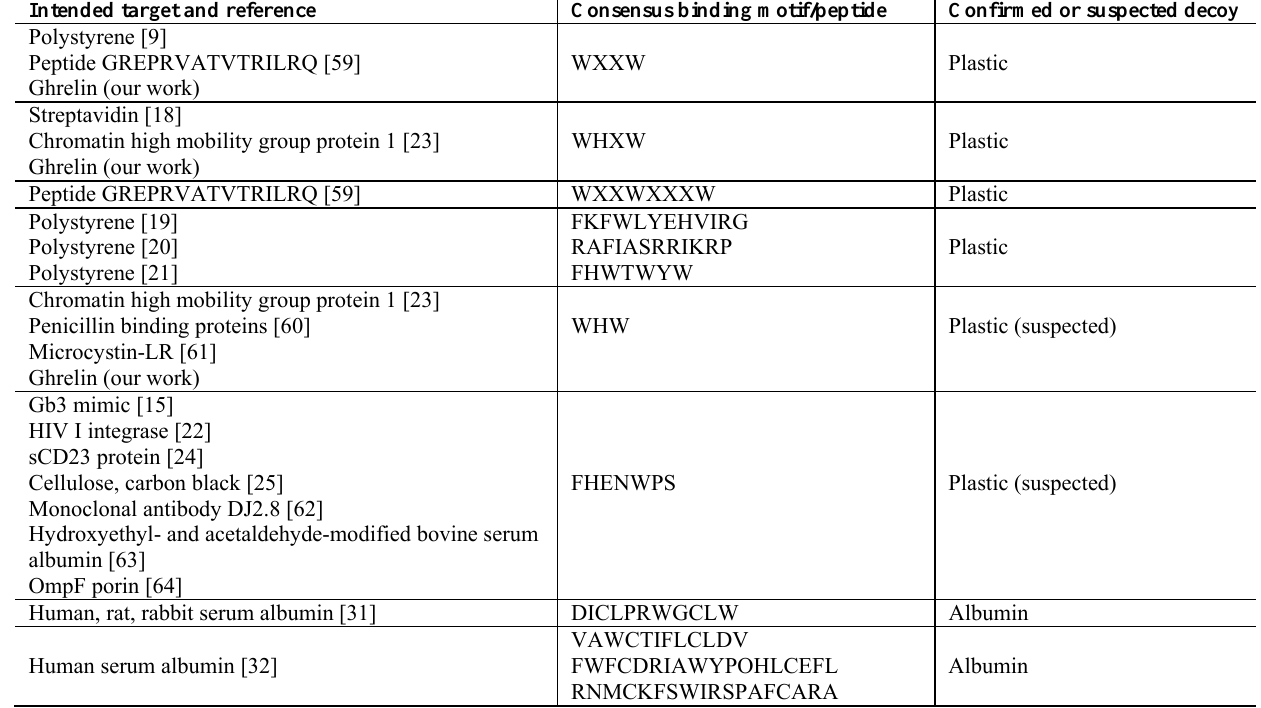
Table 1. Peptides binding to different components of screening